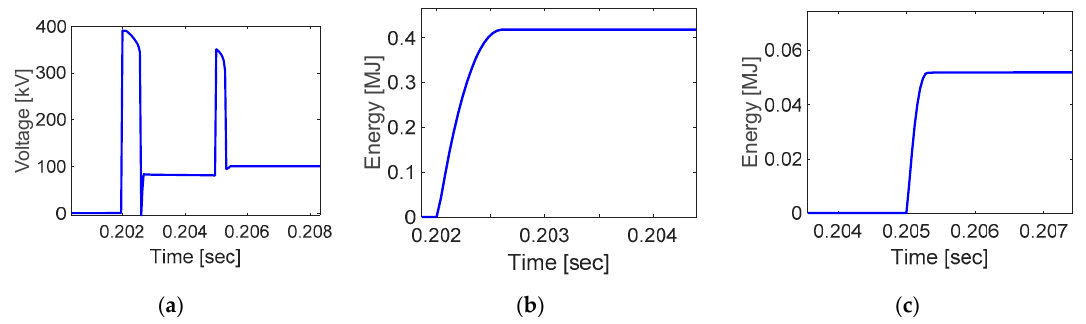
Figure 13. Miscellaneous results: ( a ) voltage across breaker; ( b ) energy absorbed by MOA ov ; ( c ) energy absorbed by MOA m.